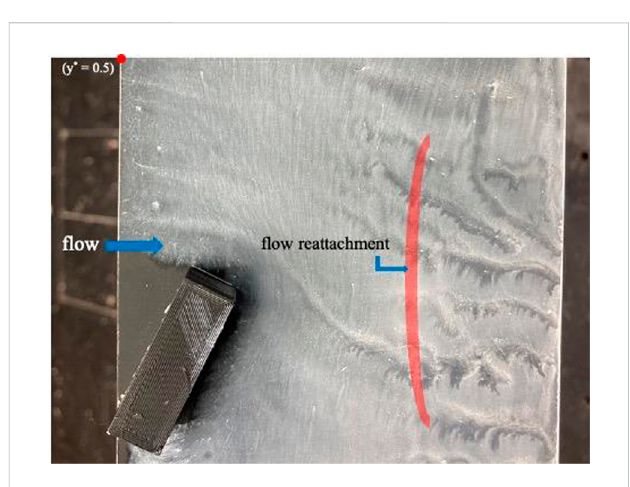
FIGURE 6 Surface oil fl ow visualization for a thin fl at-plate at α = 45 ° with the installation of